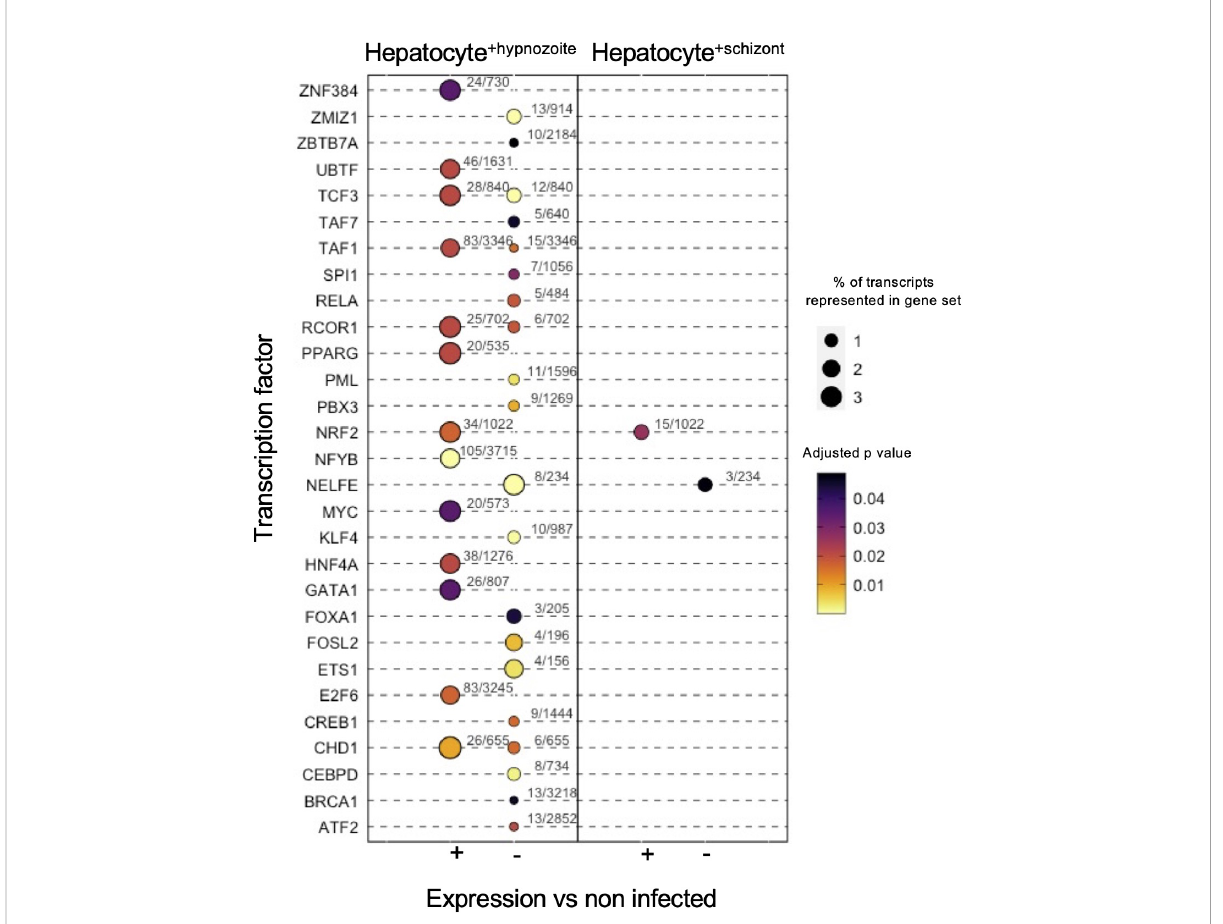
FIGURE 7 Transcription factor enrichment in hepatocytes infected with schizonts or hypnozoites. Dot plot of transcription factors enriched in Hepatocyte +hypnozoite (left) or Hepatocyte +schizont sets (right). Positive (+) enrichment derived from genes displaying greater expression versus non-infected hepatocytes; negative (-) enrichment derived from genes displaying decreased expression versus noninfected